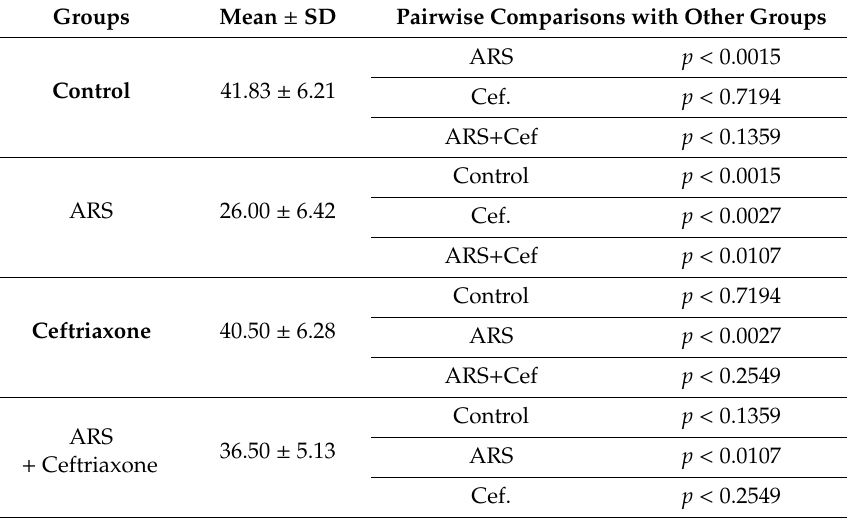
Table 4. Morphometric analysis of the pyramidal neuron count in the CA3 region of the hippocampus. Groups Mean ± SD Pairwise Comparisons with Other Groups Control 41.83 ±